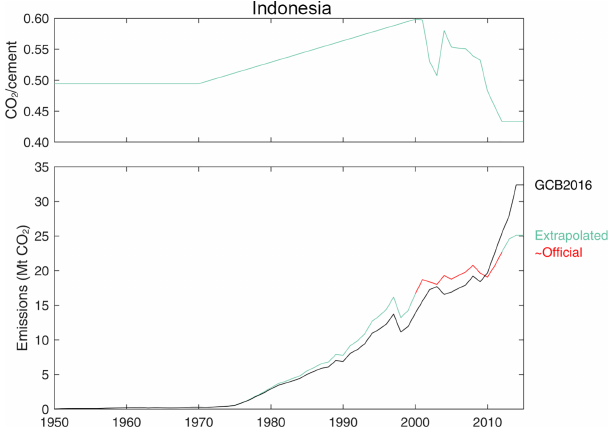
Figure D17. Revised cement emissions for Indonesia.